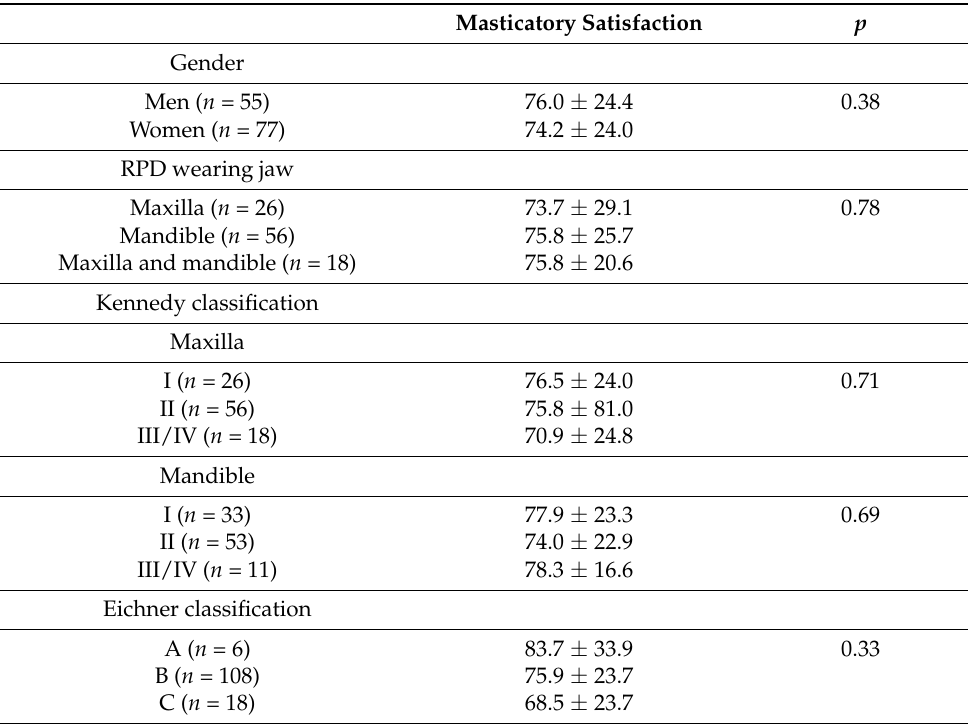
Table 4. Relationship between masticatory satisfaction and survey items.